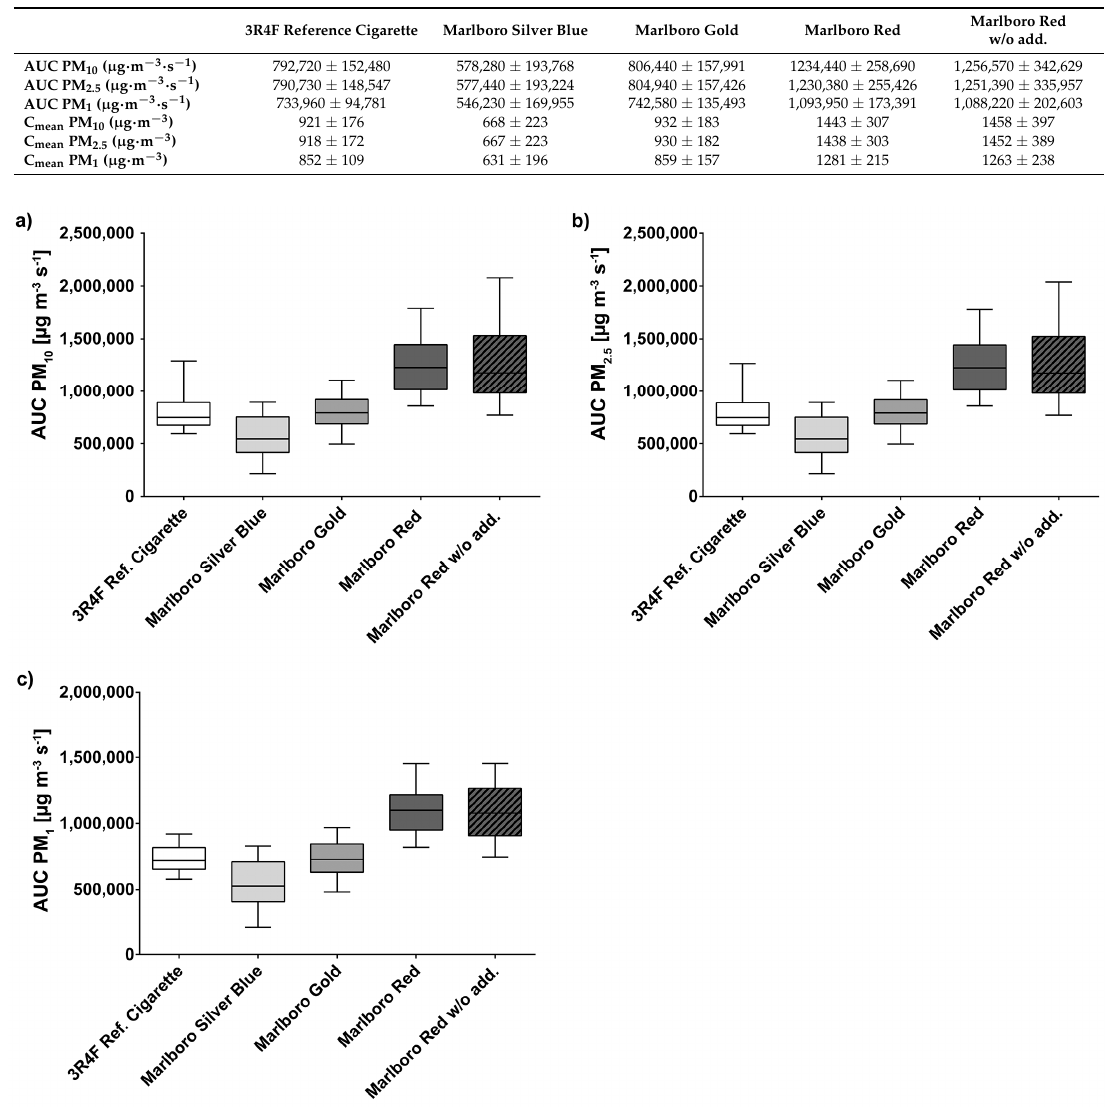
Figure 1. Comparative boxplot (min to max whiskers) of area under concentration–time curve (AUC)–PM of all tested cigarette brands. ( a ) AUC-PM 10 , ( b ) AUC-PM 2.5 , ( c ) AUC-PM 1.